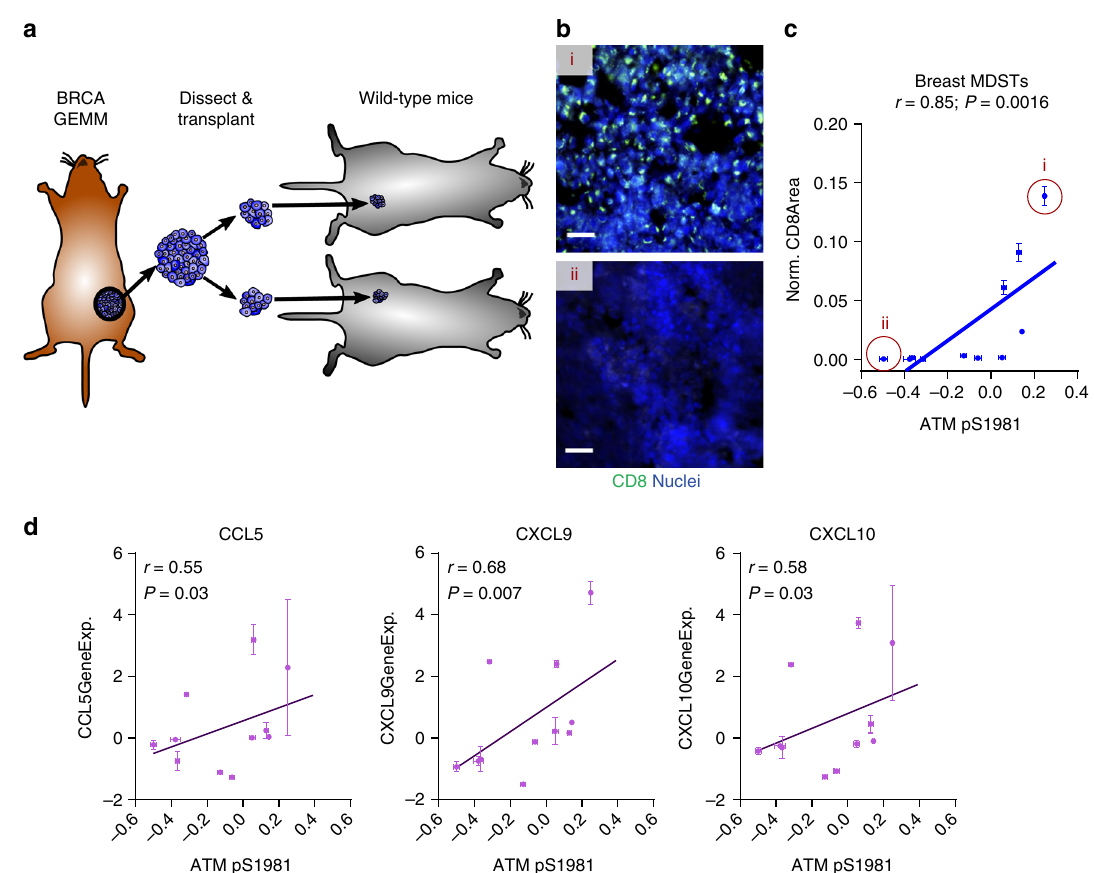
Fig. 7 ATM phosphorylation correlates with CTL invasion and cytokine expression in a murine breast cancer model. a Schematic of murine derived syngeneic transplant (MDST) model. b Representative CD8 (green) immunostaining with DAPI nuclear counterstain (blue) of MDST tumor sections for a CTL-high MDST (i) and CTL-low MDST (ii). Scale bar = 50 μ m. c Correlation of ATM pS1981 determined by RPPA with CD8 immunostaining ( N = 11 MDST models). Normalized CD8 area was determined by taking the area staining positive for CD8 normalized to the entire area of the tissue section determined by auto fl uorescence. Models shown in b are indicated. Spearman correlation coef fi cient (r) and corresponding P -value indicated above plot. Error bars represent sample standard errors. d Correlation of ATM pS1981 determined by RPPA with gene expression values for CCL5 , CXCL9 , and CXCL10 in the MDST model ( N = 11 MDST models). Spearman correlation coef fi cient (r) and corresponding P -value indicated above plot. Error bars